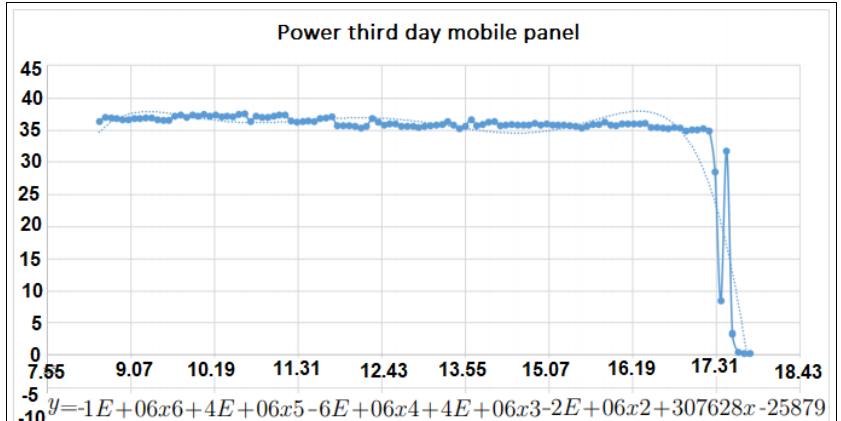
Figure 21: Graph of power generated third day with mobile